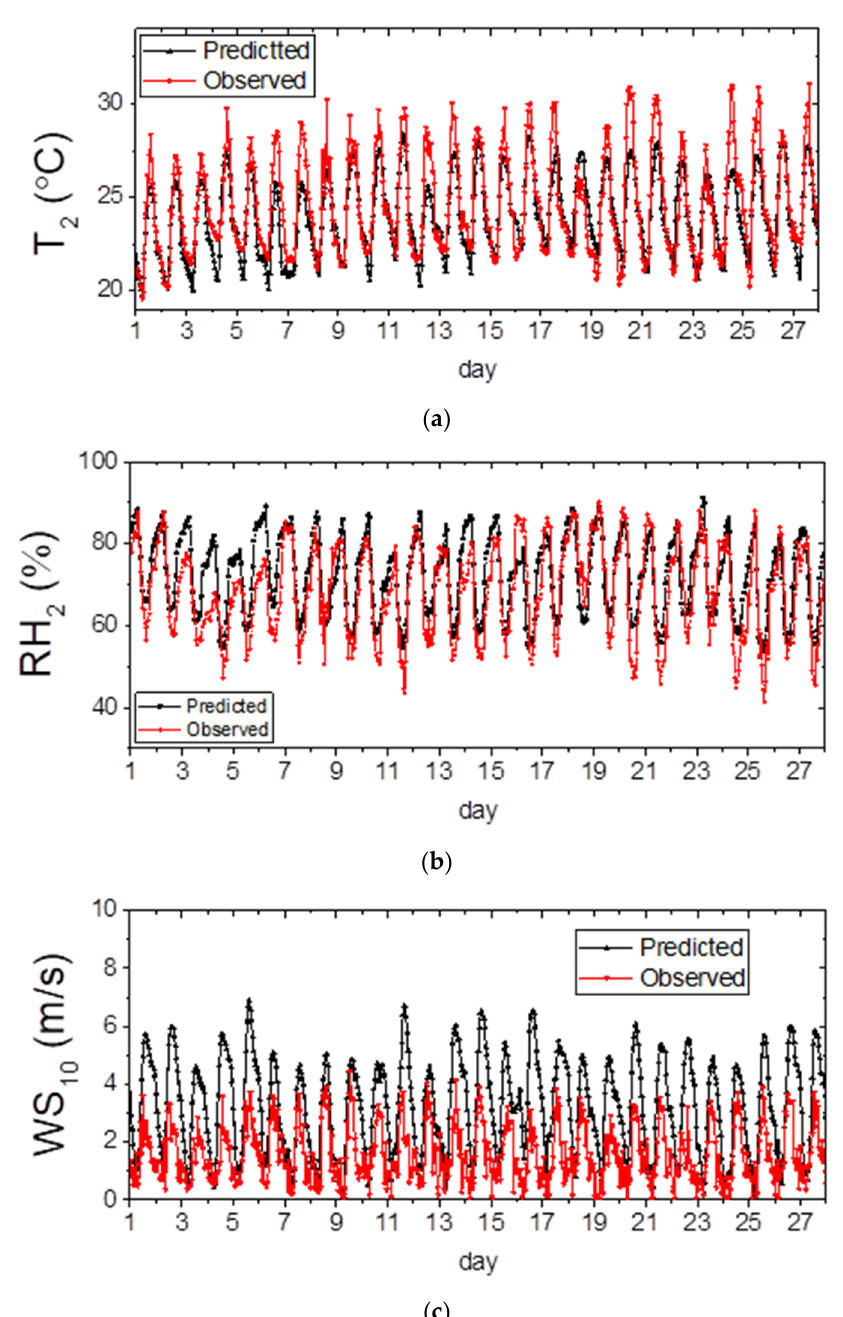
Figure 6. Comparison between measured and simulated hourly meteorological variables for case– control (Control) scenario for ( a ) temperature, ( b ) relative humidity (RH), and ( c ) wind velocity. Table 3. Comparison of meteorological variables for Lima for case-control (Control).